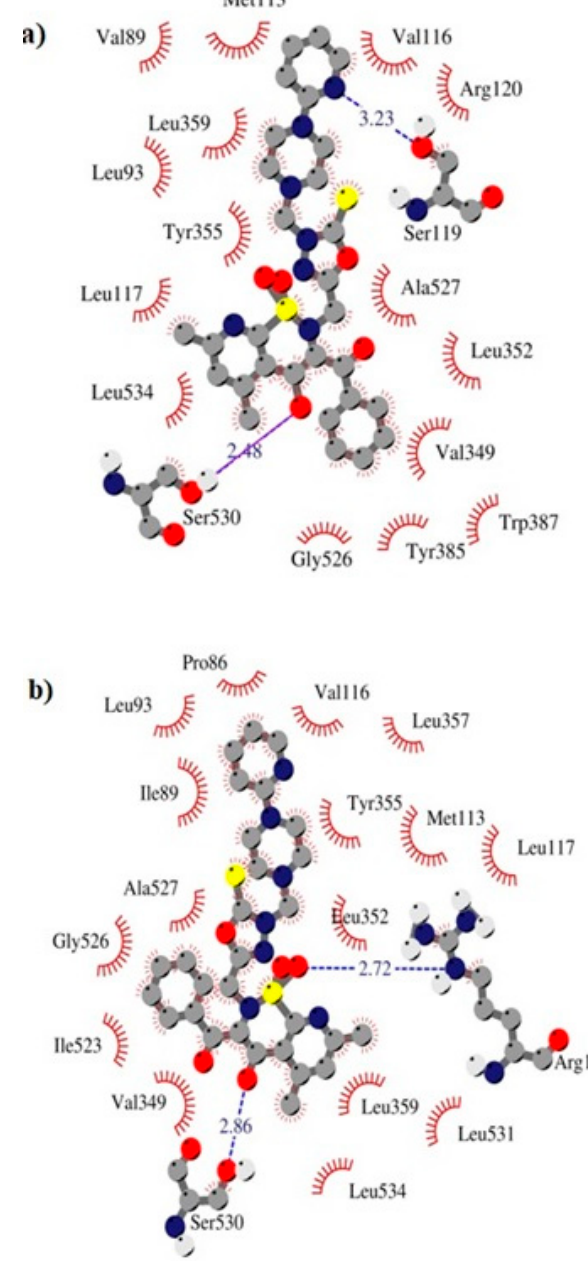
Figure 8. Intermolecular interactions between compound TG11 and cyclooxygenase: ( a ) COX-2 and ( b ) COX-1.